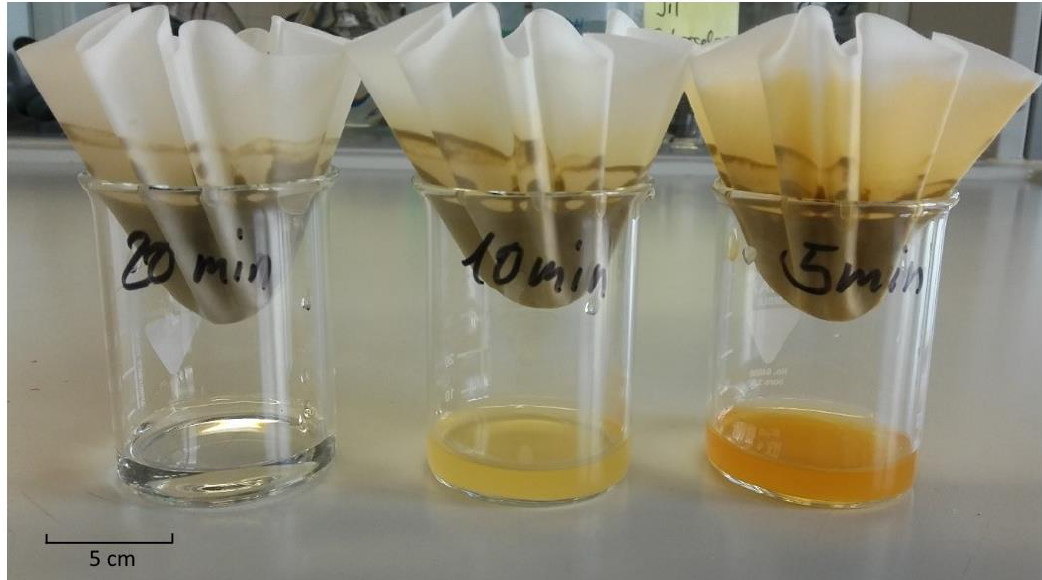
Figure 5. Suspension in the 5, 10 and 20 min samples after treatment with coal fly ash.